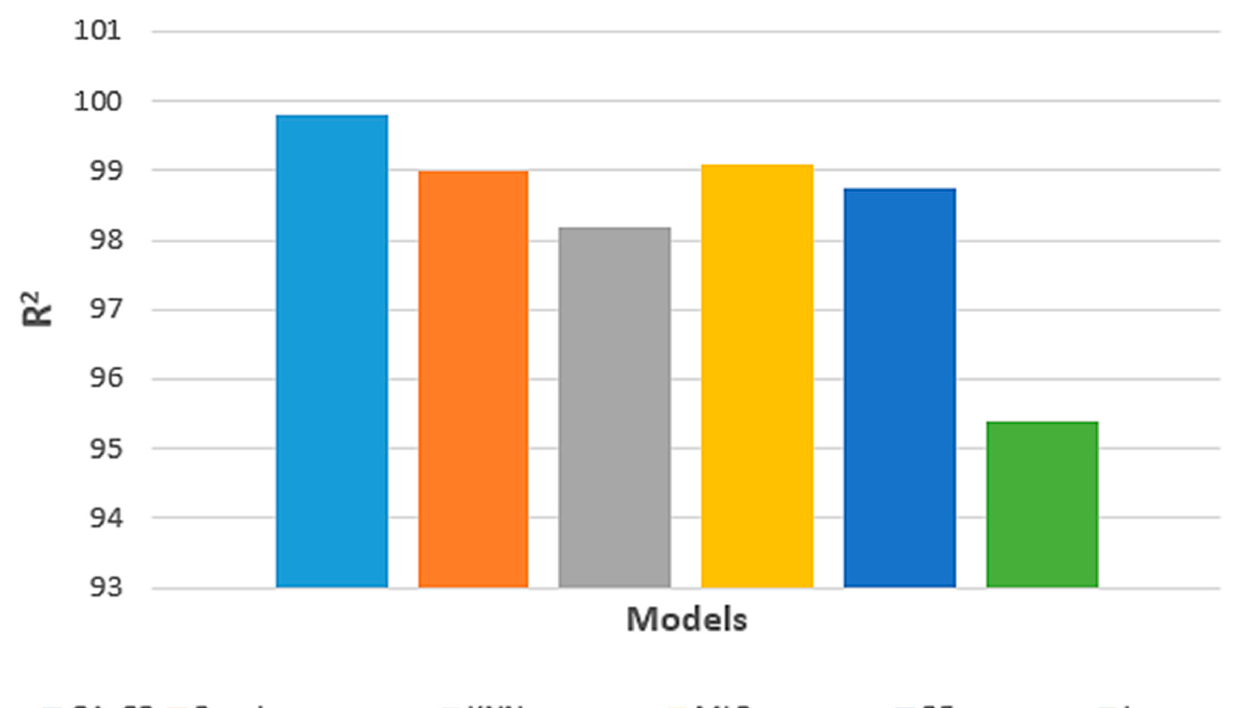
Figure 2. Comparison between the models used in the term of coefficient of determination ( R 2 ) using OProd dataset.